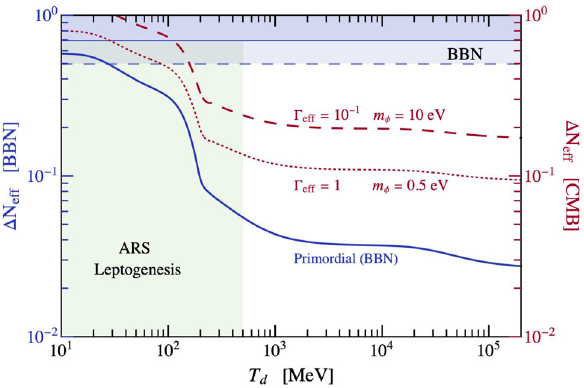
Fig. 2 Contribution from a primordial majoron population to (cid:2) N eff at BBN (blue), assuming m φ (cid:8) 1 MeV, as a function of decoupling temperature T d (obtained using the entropy density in the SM from [108]). For majorons with (cid:15) eff (cid:2) 1 and m φ (cid:3) 0 . 1 eV, the contribution to (cid:2) N eff at recombination (red) can be greatly enhanced due to the fact thatmajorons donot decayimmediatelyafterbecomingrelativistic;this point is illustrated for (cid:15) eff = 10 − 1 and m φ = 10 (dashed). In green we show the approximate parameter space relevant for ARS leptogenesis, see Eq. (19). We show two constraints from BBN (dark and light blue horizontal regions; to be compared with blue solid line) which arise from two different determinations of Y p [109,110], see Appendix C